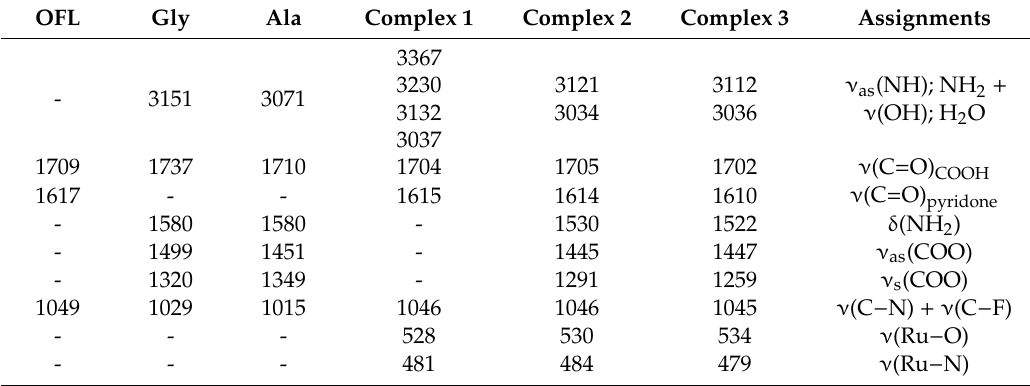
Table 3. IR spectral bands (cm − 1 ) of free OFL, Gly, Ala, and the synthesized complexes. OFL Gly Ala Complex 1 Complex 2 Complex 3